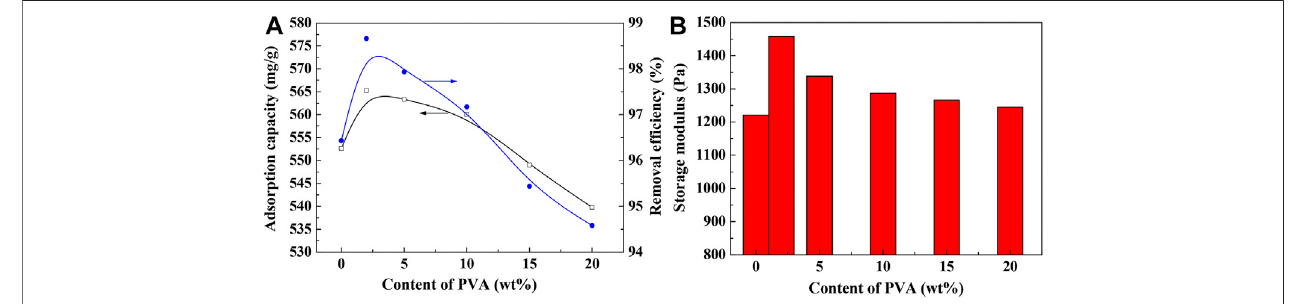
FIGURE4| EffectofPVAcontentontheadsorptioncapacity (A) andthegelstrength (B) .Adsorptionconditions:initialPb(II)concentration,1,150 mg/L;adsorbent dosage, 2 g/L; adsorption time, 120 min; pH, 5.0; adsorption temperature, 30 ° C.